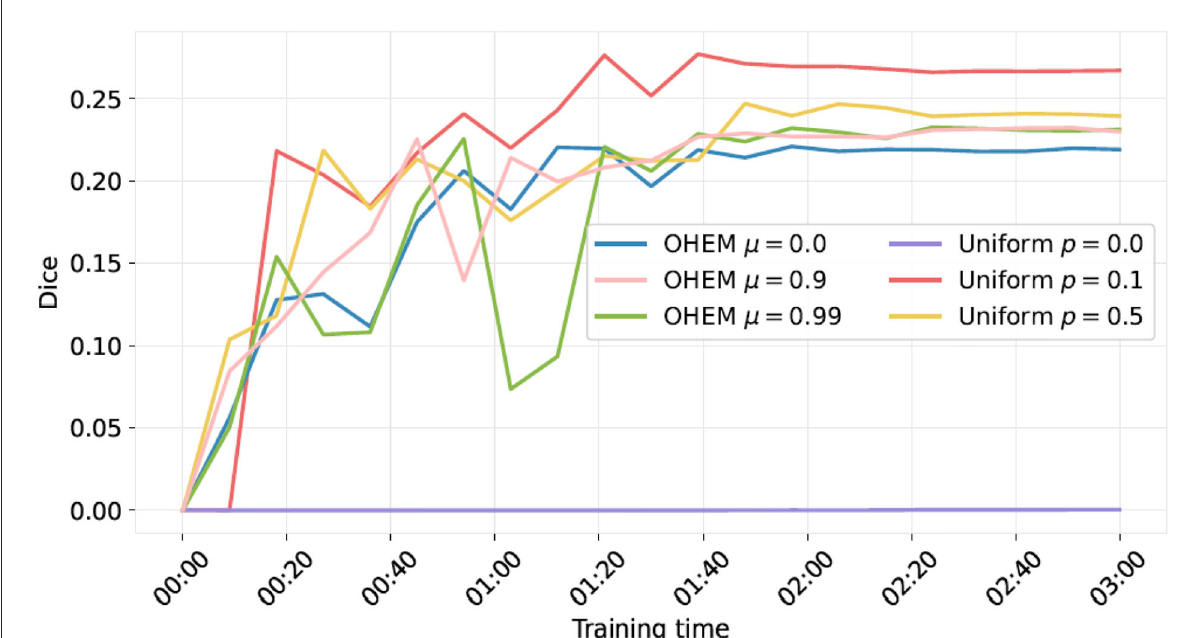
FIGURE2 Evolution of the Dice score as a function of training time for the OHEM and the forced oversampling procedure (denoted as “Uniform”). For OHEM, µ is the momentum. For “Uniform”, patches were sampled with respective probabilities, p for those with new lesions, and 1-p for the rest (not necessarily without new lesions). One can observe that the “Uniform” procedure with p > 0 ended up performing best and that, when using OHEM, choosing µ > 0 seems to be